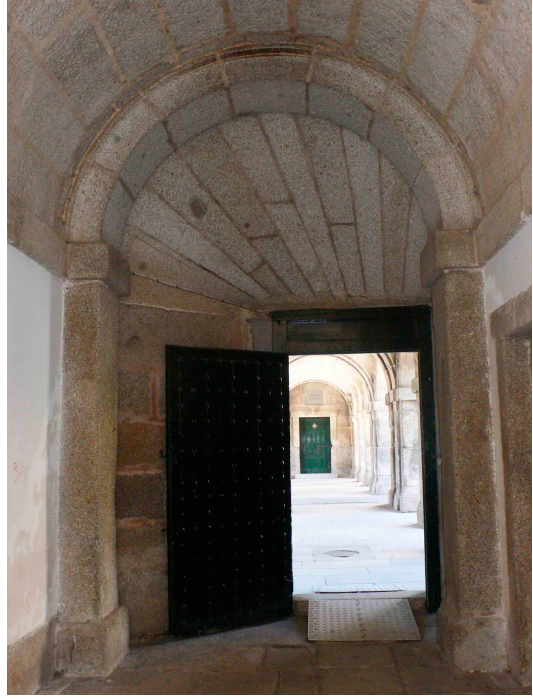
Figure 18. Arcade to the Compaña as seen from the Botica. The stereotomy of the vault must be stressed. Photograph by the authors.